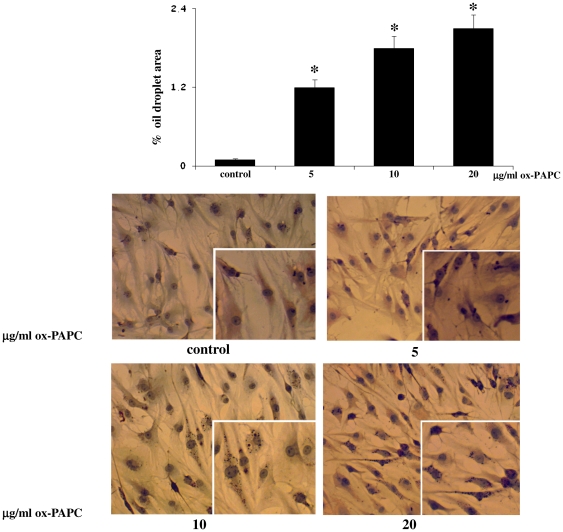
OIL Red O staining.When the hMSCs were cultured for 72 h in presence of ox-PAPCs during adipogenic differentiation, they showed a dose dependent significant increase of lipid-folled droplets (p<0.05). (original magnification 20×, insert 40×). The percentage of area stained with OIL Red O (red droplets) was quantified by using the IMAGE J Software.